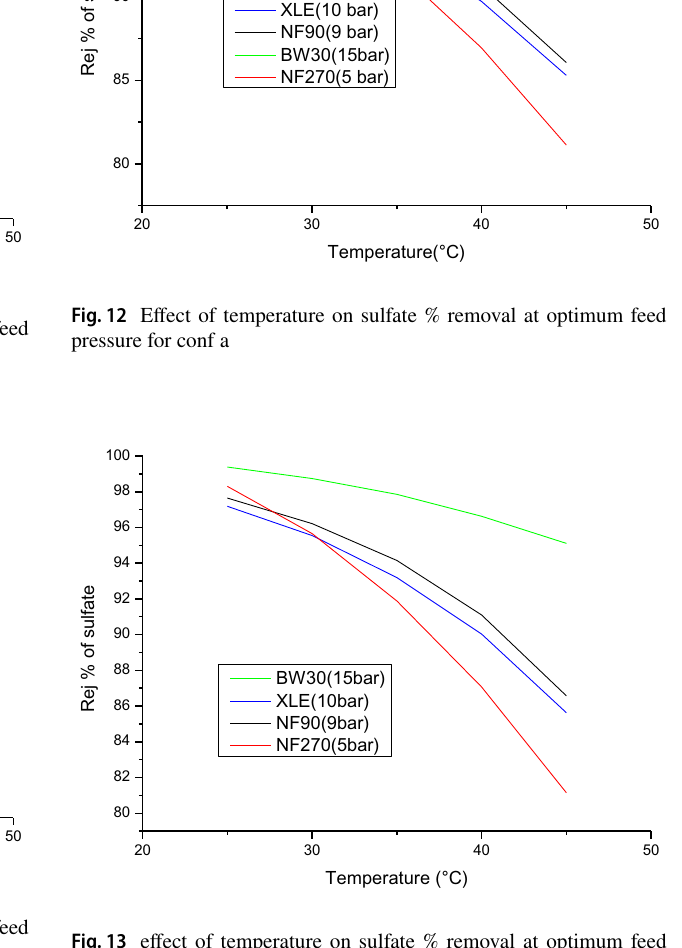
Fig. 13 effect of temperature on sulfate % removal at optimum feed pressure for conf